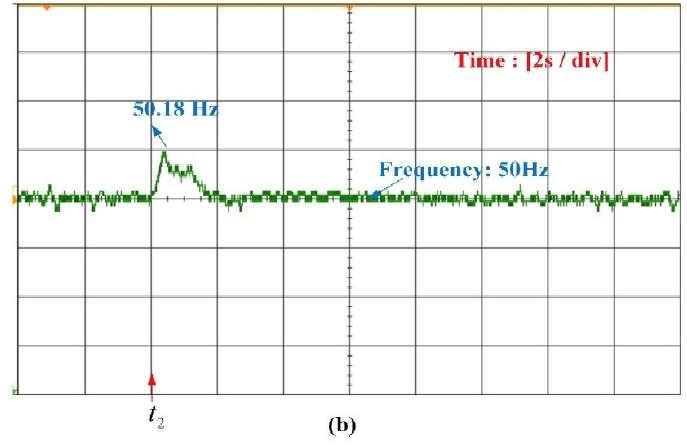
Figure 21. Source side Variations ( a ) power from SC and grid; ( b ) frequency.